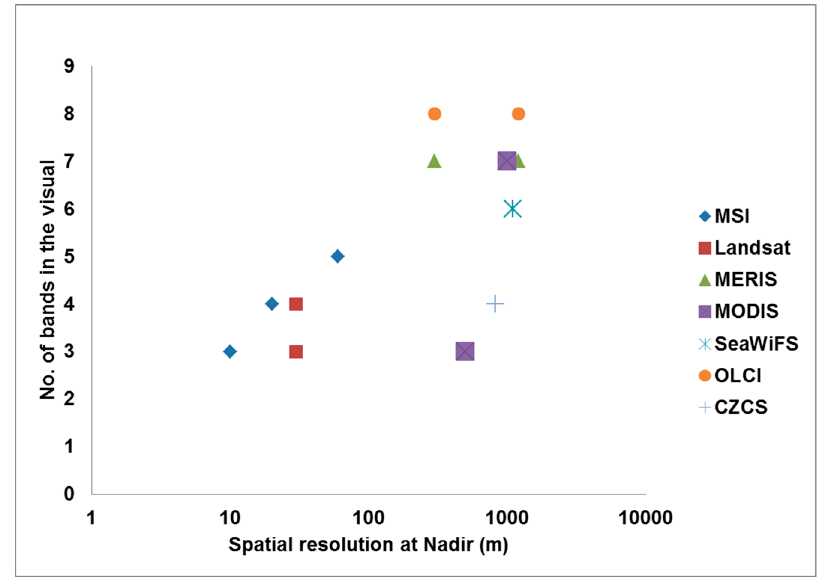
Figure 1. Plot of the available spectral bands in the visual range (400–710 nm) as function of spatial resolution for seven types of sensors. The multispectral imager (MSI) provides three different resolution modes, Landsat 8 has one band more than Landsat 7 at 30-m resolution. The Medium Resolution Imaging Spectrometer (MERIS), Moderate Resolution Imaging Spectroradiometer (MODIS) and Ocean and Land Colour Instrument (OLCI) provide products at two resolutions.